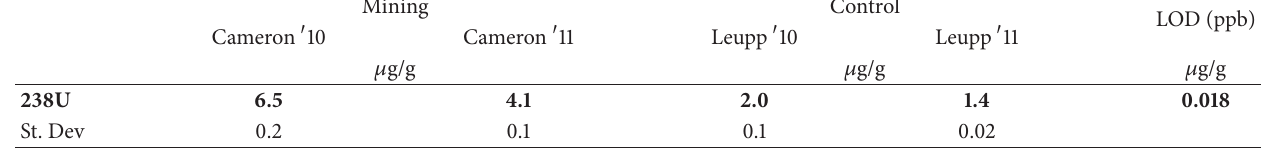
Table 3: The average metal found of the four soil samples ( 𝜇 g/g), along with the limit of detection for each metal.